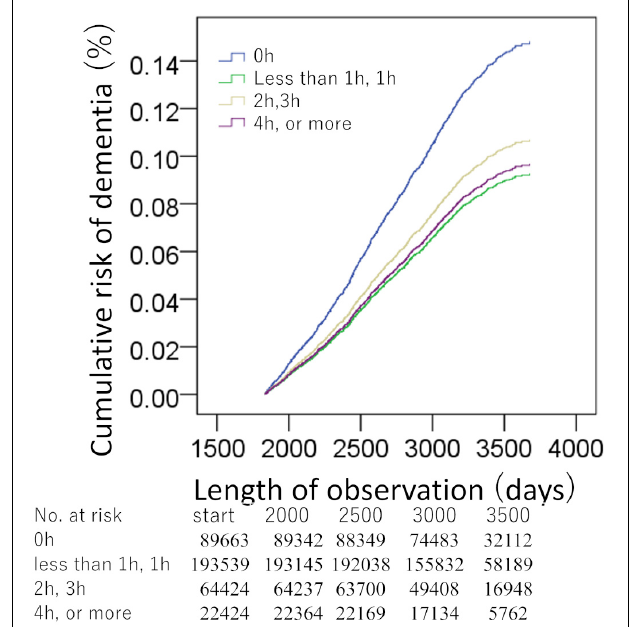
FIGURE 2 | Standardized risks of incident dementia over time according to the daily driving time. Cox proportional hazards models were adjusted for potential confounding variables. There were significant differences between the group of less than 1 h, or 1 h, and the other groups.